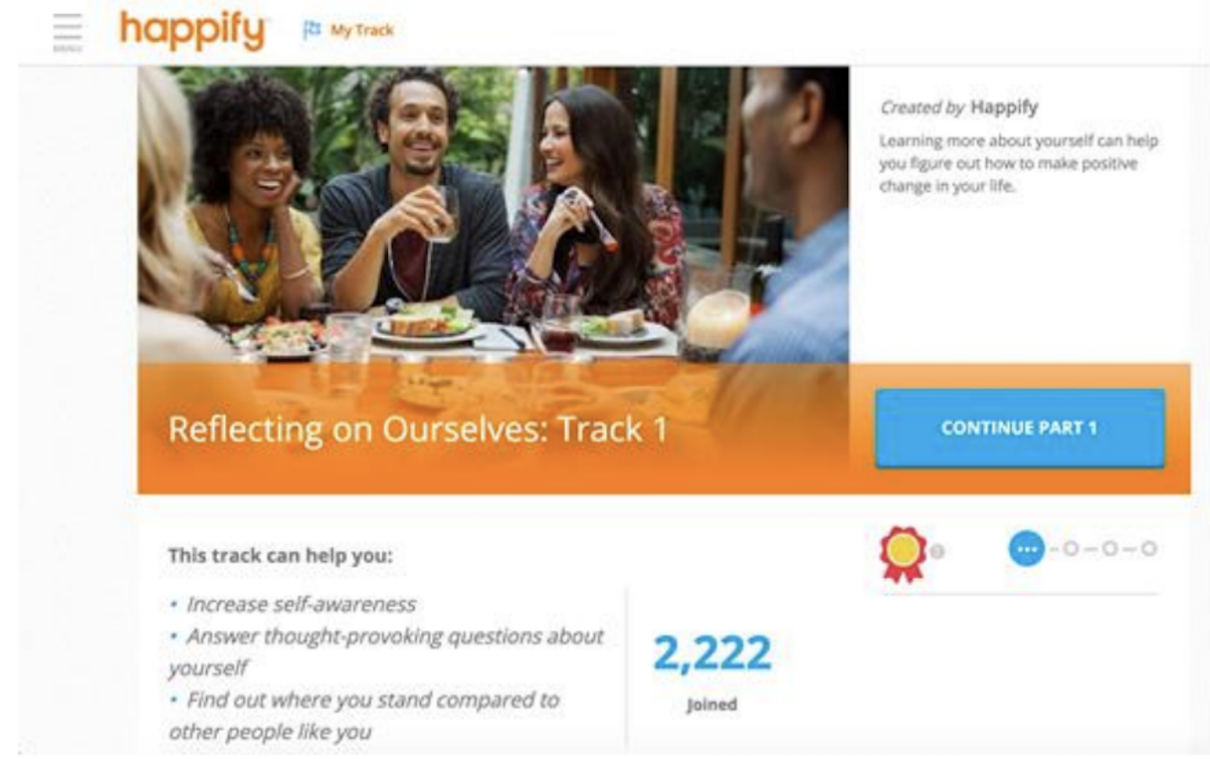
Figure 2. Screenshot of the track description in sham digital